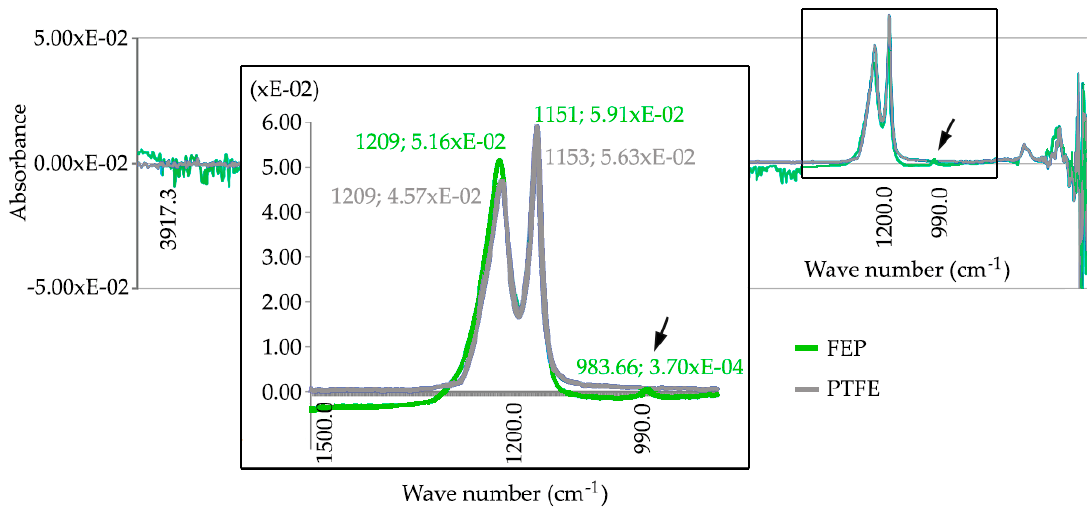
Figure 6. The characteristic absorbance (cm − 1 ) presented in the FEP and PTFE coatings.